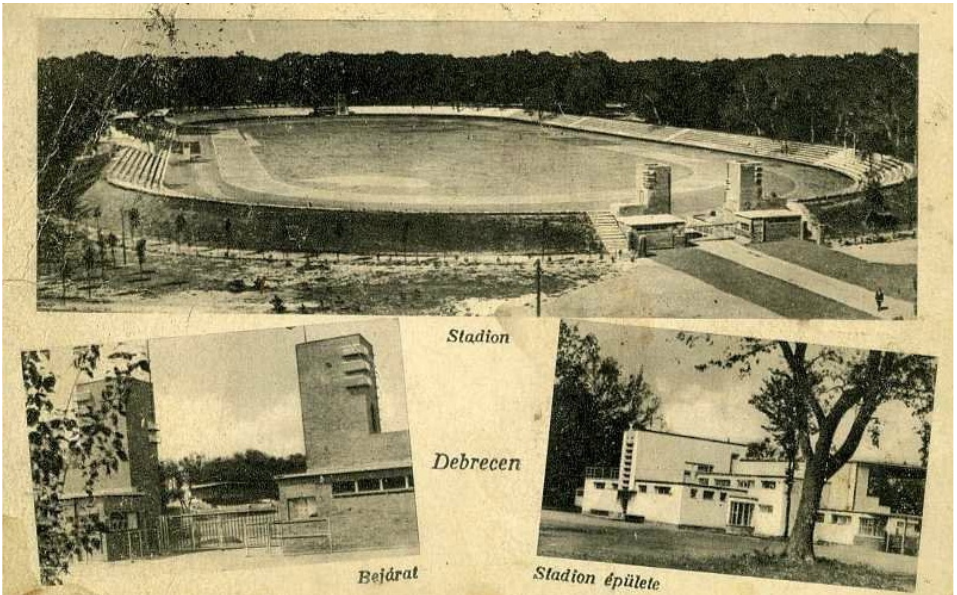
Figure 4. Great Forest Stadium in the 1930s. Source: own photo collection.